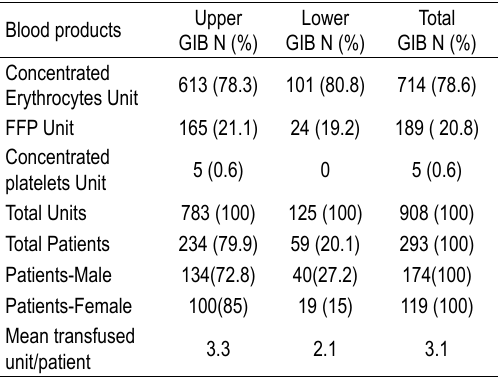
Table 2. transfusion treatment with blood products in pa- tients with Gastro intestinal Bleeding